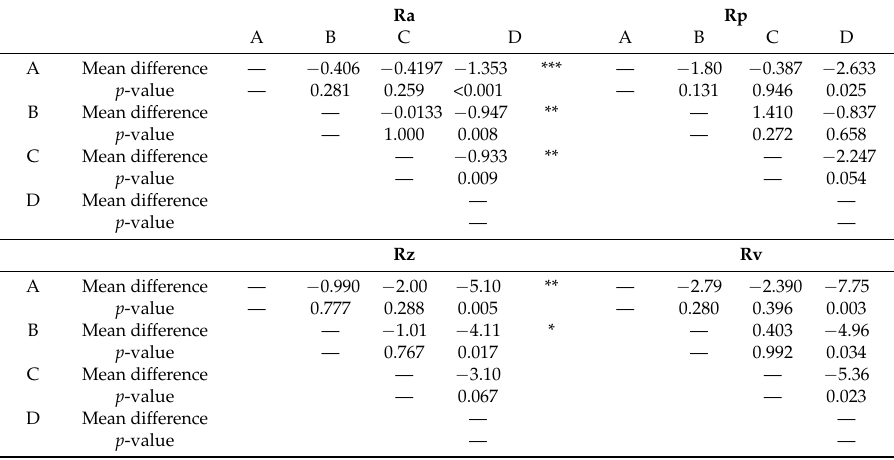
Table 6. Tukey Post-Hoc Test.